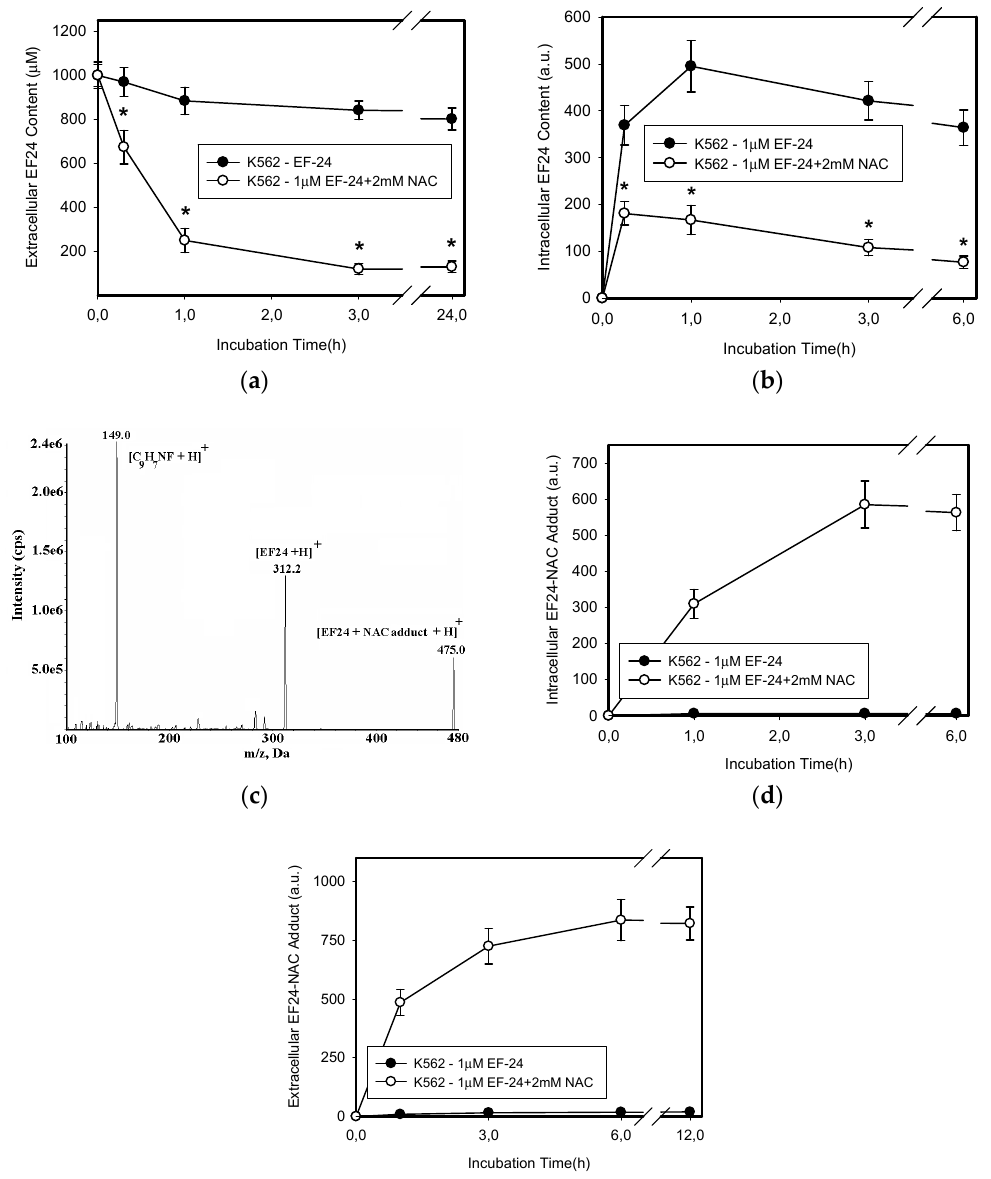
Figure 6. Effect of NAC on extracellular and intracellular levels of EF-24. Cells were treated with EF-24 or with EF-24 + 2 mM NAC. At indicated time intervals, extracellular and intracellular levels of EF-24 were determined using LC/MS/MS analysis. ( a ) Extracellular EF-24 level; * denotes significant change in EF-24 content in growth medium ( p < 0.05) between EF-24 and EF-24 + NAC-treated K562 cells. ( b ) Intracellular EF-24 level; * denotes significant change in intracellular EF-24 content ( p < 0.05) between EF-24 and EF-24 + NAC-treated K562 cells. The experimental points represent mean values from three replicate experiments, with standard deviations. ( c ) MS/MS analysis of EF-24-NAC adduct: Mass spectrum of the molecular ion of [EF-24-NAC-adduct] + , m/z 475.0, result fragment ion [EF-24+H] + , m/z 312.2, and [C9H7NF + H] + , m/z 149.0. ( d ) Time course of intracellular EF-24-NAC adduct formation. Cells were treated with EF-24 or with EF-24 + NAC for given incubation time. The amount of EF-24-NAC adduct in cells was determined using LC/MS/MS. ( e ) Time–course of extracellular EF-24-NAC adduct formation. Cells were treated with EF-24 or with EF-24 + NAC for given incubation times. The amount of EF-24-NAC adduct in growth medium was determined using LC/MS/MS. The experimental points represent mean values from three replicate experiments, with standard deviations.